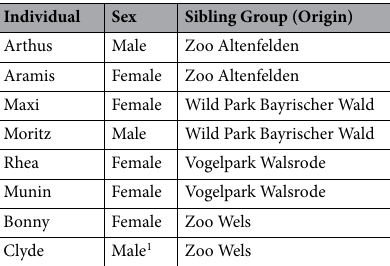
Table 2 The ravens. Table 2 provides information about the tested birds (name, sex, and sibling group named after their origin). 1 Individual stopped participating during the second set of experiments and was not tested